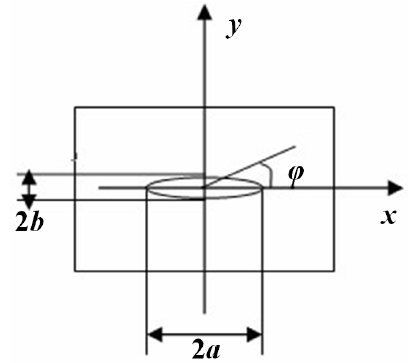
Figure 2. Floor plan of the embedded elliptical